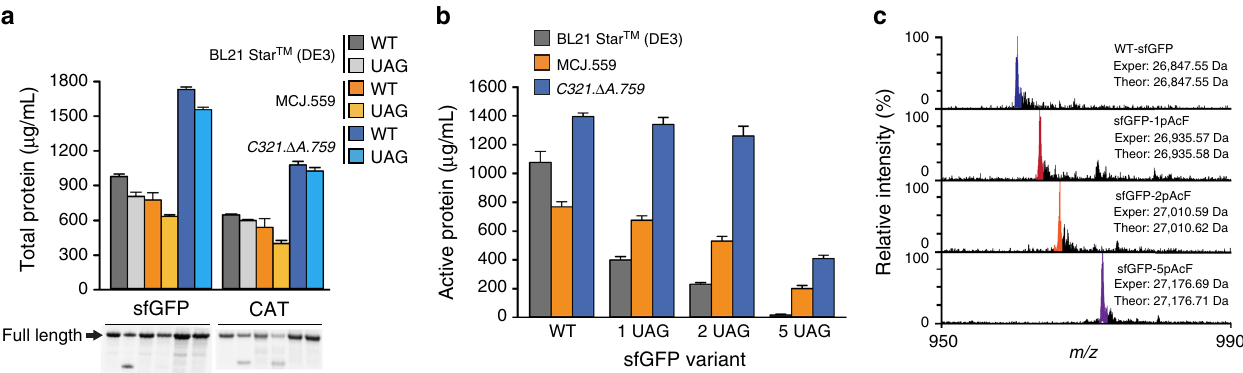
Fig. 3 Multi-site incorporation of pAcF into proteins. Cell-free p -acetyl- L -phenylalanine (pAcF) incorporation was compared using extracts derived from BL21 Star (DE3), MCJ.559, and C321 . Δ A . 759 strains containing the pEVOL-pAcF vector. The pEVOL-pAcF vector harbors the orthogonal translation machinery necessary for pAcF incorporation. a Total protein yields for wild-type (WT) and 1 UAG versions of superfolder green fl uorescent protein (sfGFP) and chloramphenicol acetyl transferase (CAT) are shown along with an autoradiogram of the resulting protein product. Supplementary Fig. 8 shows the entirety of the autoradiogram along with a molecular weight marker. b Multi-site incorporation of pAcF into sfGFP variants as quanti fi ed by active protein produced. The sfGFP variants used were wild-type (WT), sfGFP containing a single pAcF corresponding to the position of T216 (1 UAG), sfGFP containing sfGFP containing two pAcFs (2 UAG), and sfGFP containing fi ve pAcFs (5 UAG). Three independent batch CFPS reactions were performed for each sample at 30 °C for 20 h ( n = 3). Error bar = 1 SD. c Spectrum of the 28 + charge state of sfGFP, obtained by top-down mass spectrometry and illustrating site- speci fi c incorporation of pAcF at single and multiple sites. Experimental (Exper) and theoretical (Theor) mass peaks for each sfGFP variant are shown. Major peaks (color) in each spectrum coincide with the theoretical peaks for each species (see also Supplementary Fig. 11). Smaller peaks immediately to the right of the major peaks are due to oxidation of the protein, a common electrochemical reaction occurring during electrospray ionization.